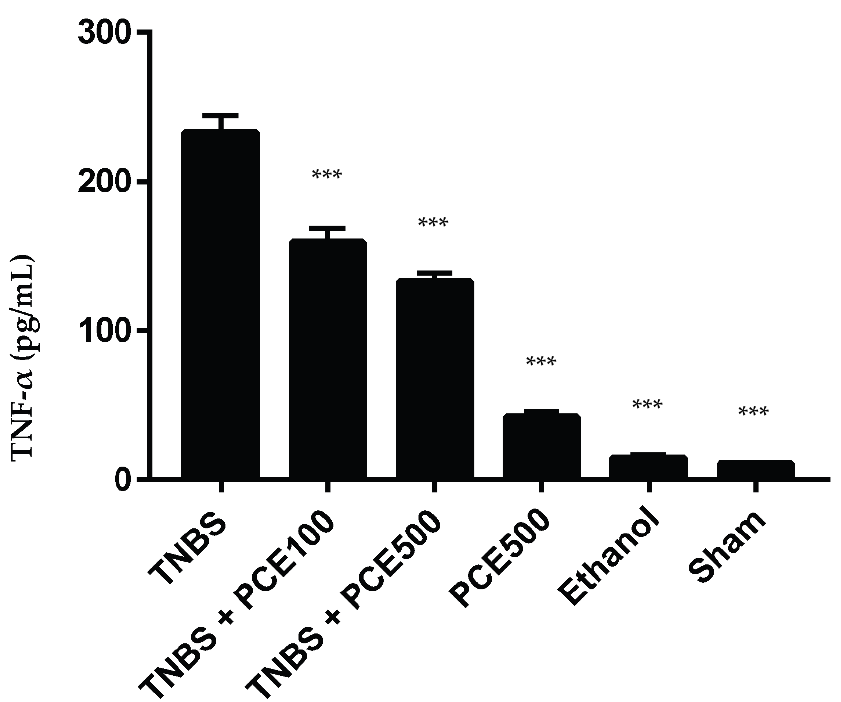
Figure 8. Effect of PCE treatment on TNF- α concentration in the IBD. The results are represented as mean ± SD [ n (TNBS + PCE100) = 10; n (TNBS + PCE500) = 10; n (PCE) = 10; n (TNBS) = 6; n (Ethanol) = 5; n (Sham) = 5; *** p < 0.001 compared with TNBS group, one-way ANOVA followed by Tukey’s post hoc test]. Abbreviations: IBD, inflammatory bowel disease; PCE, phenolic compounds extract; TNBS, 2,4,6-Trinitrobenzene sulfonic acid; TNF- α , tumor necrosis factor- α .